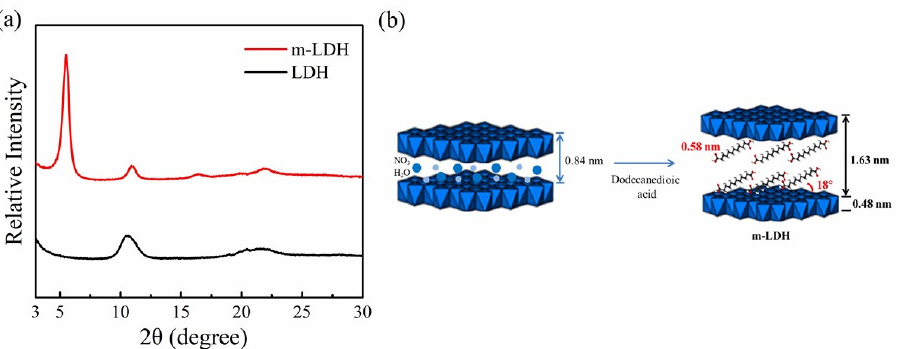
Figure 3. In situ WAXD patterns of ( a ) g-PBA, and ( b ) g-PBAT-90, crystallized at different temper- atures, as indicated on traces.